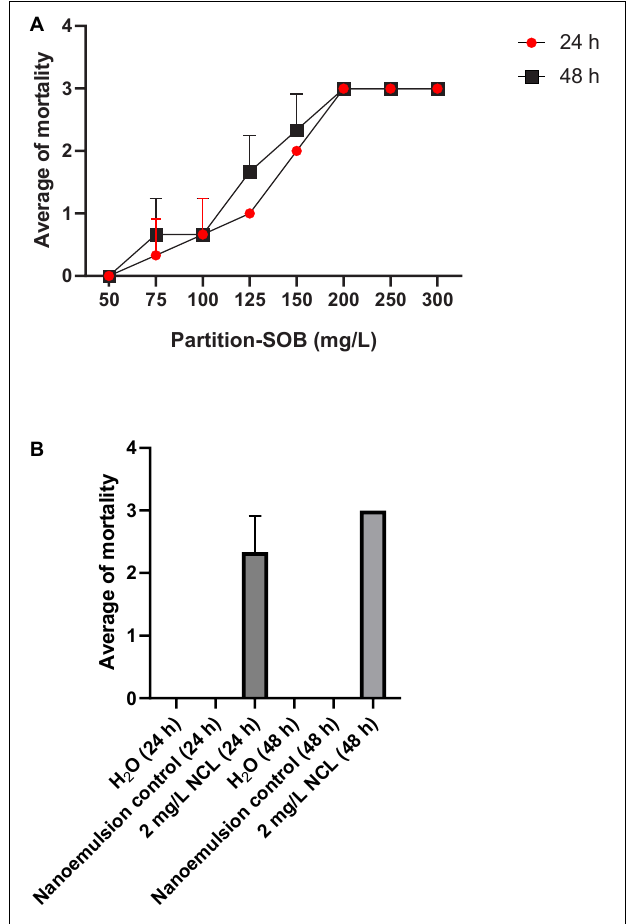
FIGURE 1 | The molluscicidal test on adult Biomphalaria glabrata for 48 h using extract-SOB (A,B) The test was performed in triplicate on different days using 27 specimens/triplicate. These data are expressed as the mean ± SD. Using the linear regression analysis, the value of R 2 is determined as 1.00.